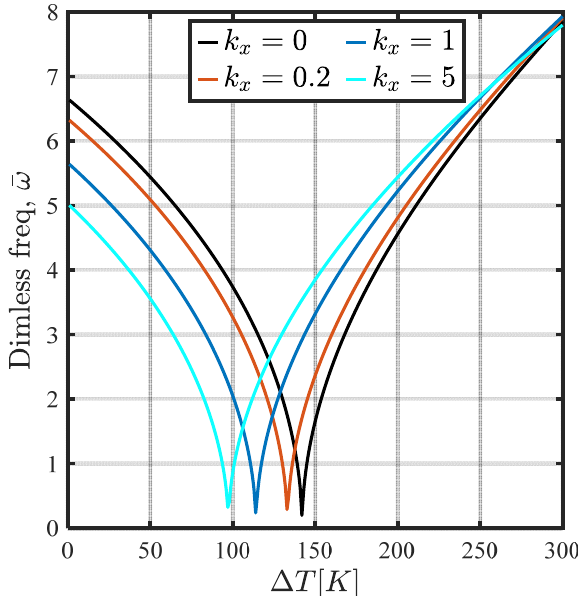
Figure 5. Influence of the axial gradient index on the dimensionless fundamental frequency at different temperature differences ∆ T under LTR and based on classical analysis ( l = 0, k z = 0.2 ) .